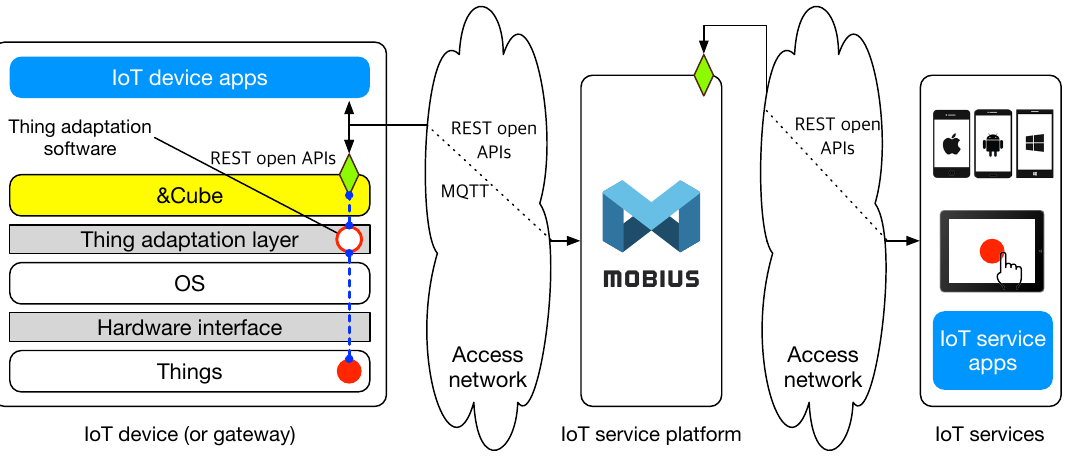
Figure 6. A use case for providing IoT services based on open APIs exposed through oneM2M IoT software platforms, &Cube and